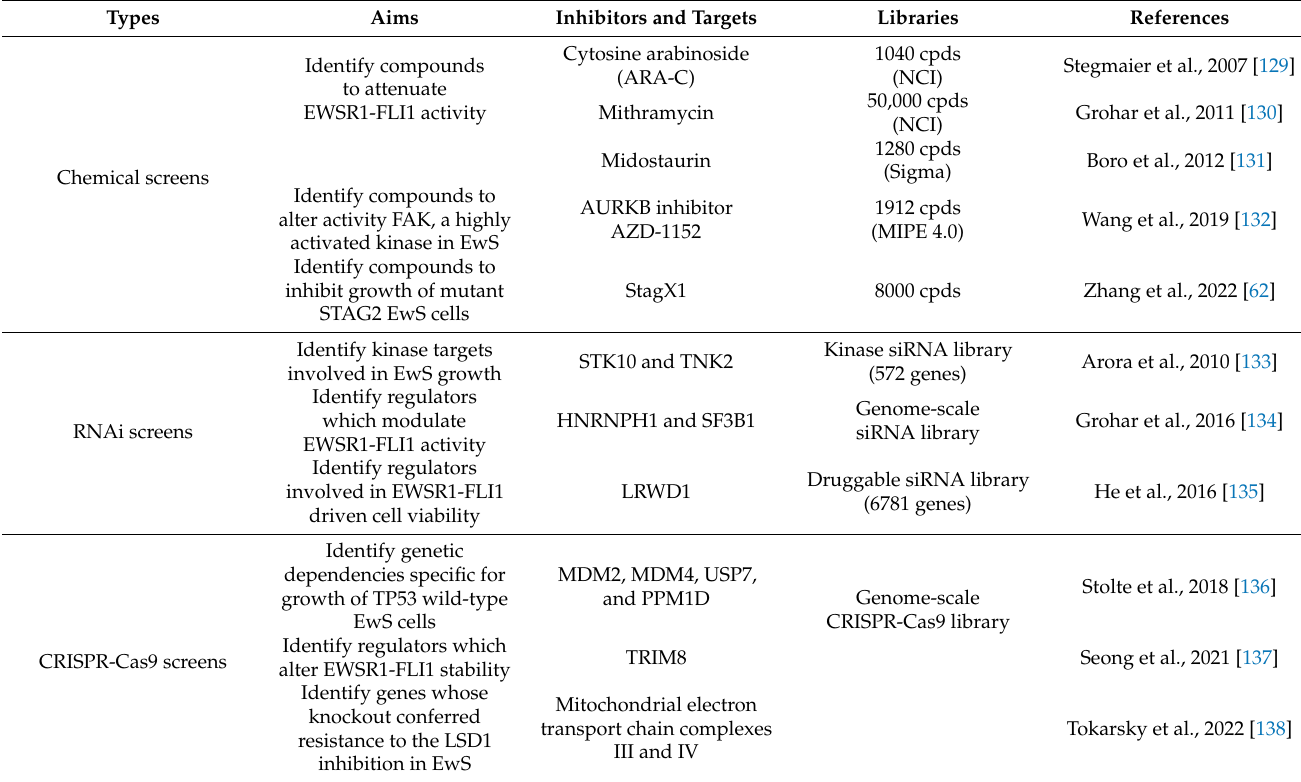
Table 1. High throughput functional screens conducted in